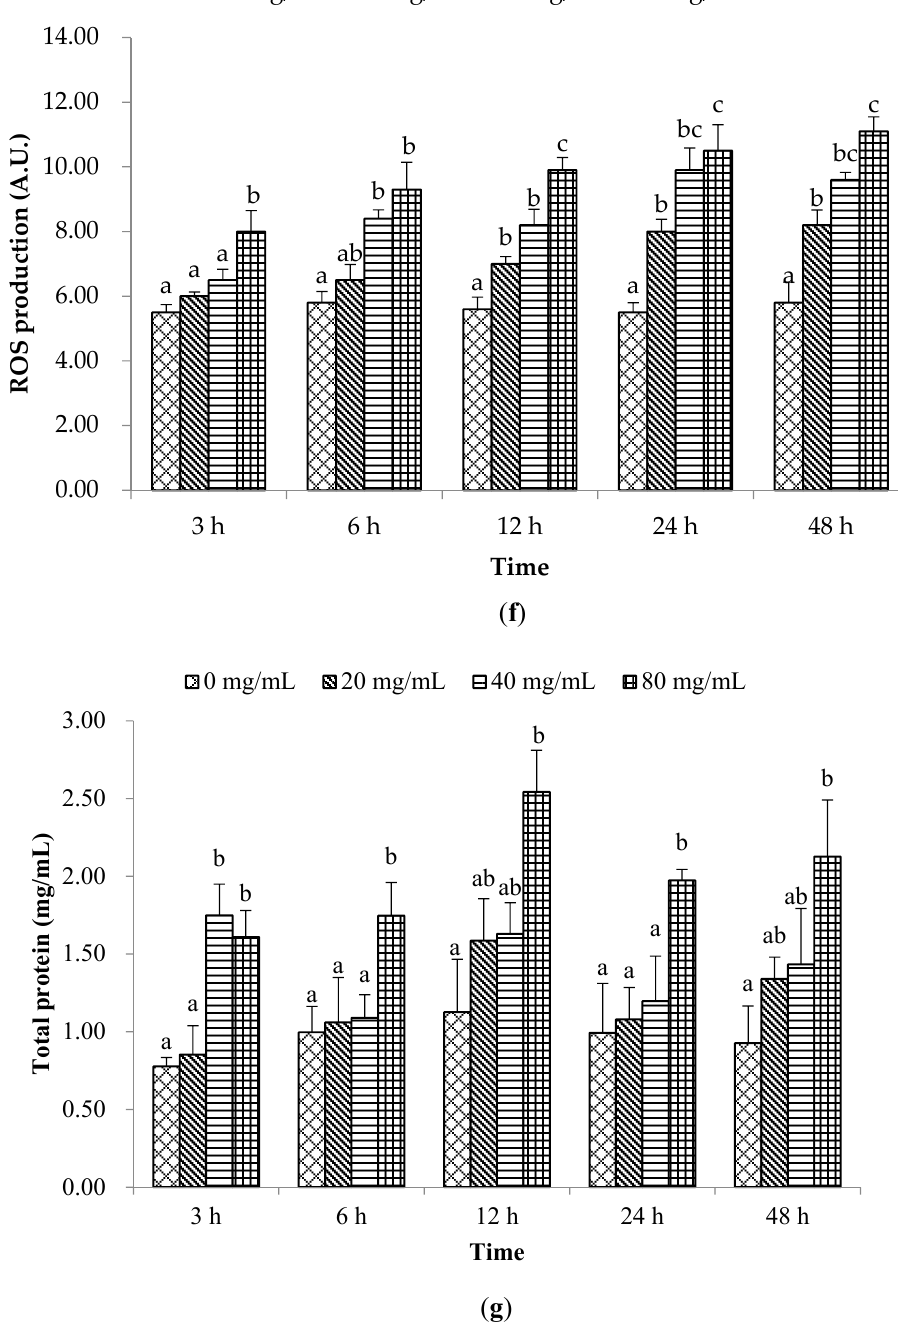
Figure 1. Effects of PA on non-special immune responses in bay scallop A. irradians at different time points after exposure to three concentrations (20, 40, and 80 mg/L). ( a ) SOD activity; ( b ) MDA content; ( c ) ACP activity; ( d ) lysozyme activity; ( e ) phagocytic activity; ( f ) ROS production ( g ) total protein; Data represent mean ± SD values ( n = 3 ) at the same sampling time with different letters denoting significant differences ( p < 0.05).